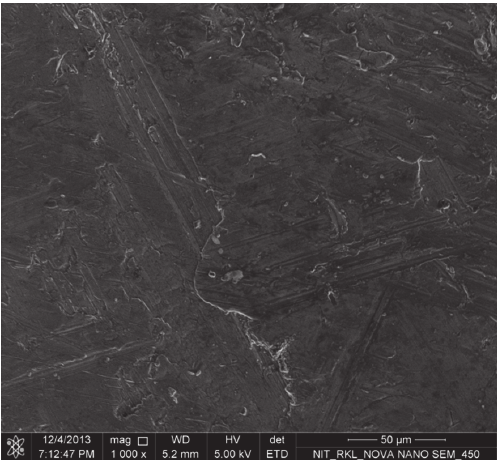
Fig. 1 . FESEM of the Al-18%SiC p MMC after casting